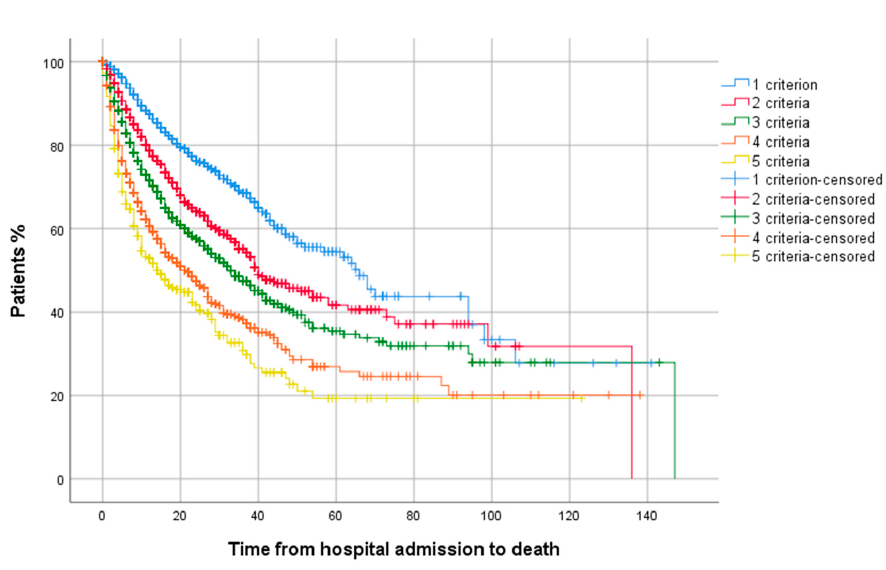
Figure 2. Time to death for high-risk patients according to the number of high-risk criteria.